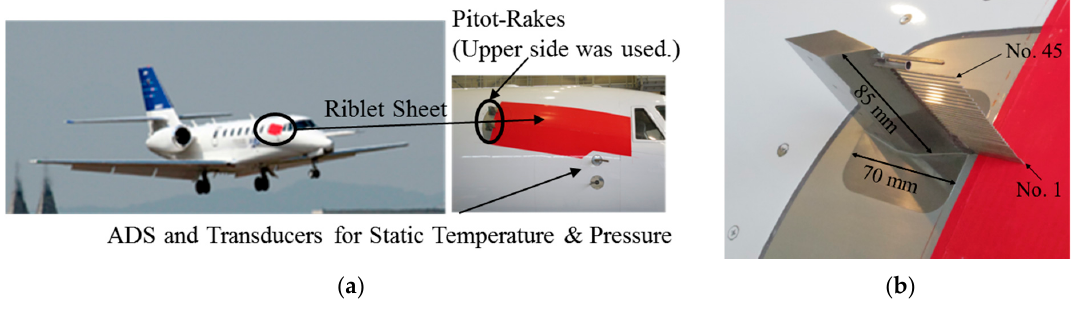
Figure 1. ( a ) Japan Aerospace Exploration Agency (JAXA) flight test bed and riblet surface attached on the aircraft surface; and ( b ) schematic of pitot-rake attached on outer surface of an aircraft.